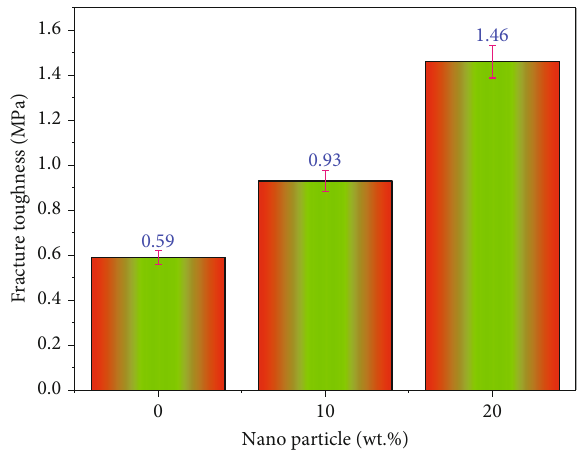
Figure 4: Fracture toughness of coir/pineapple/Al based nanocomposites.